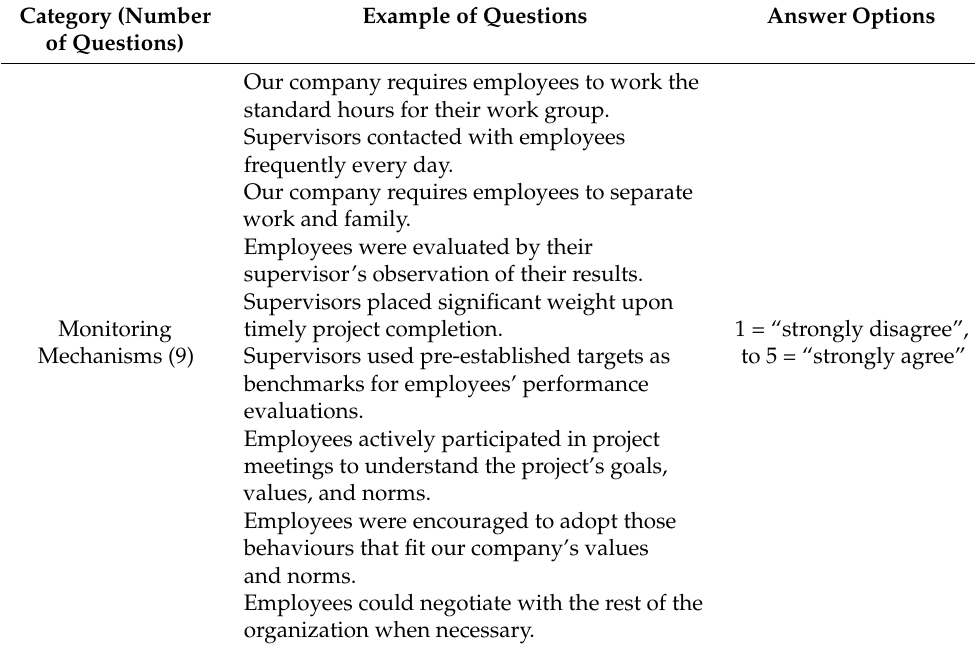
Table A1. Part A of the questionnaire on working from home arrangements and job satisfaction during the COVID-19